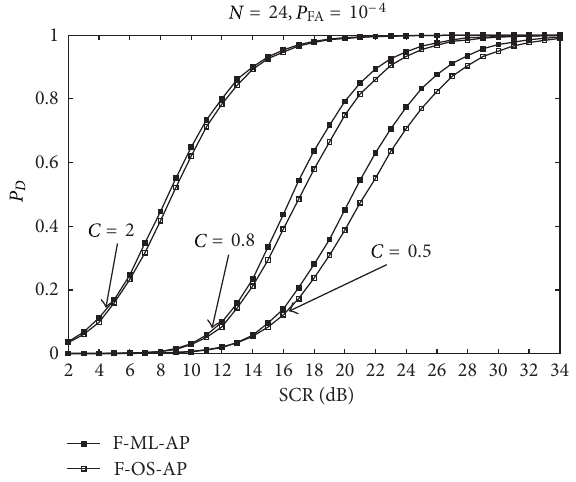
F 7: PD versus SCR performance of distributed detector based on ML CFAR algorithm in local sensors when interfering targets are presented.